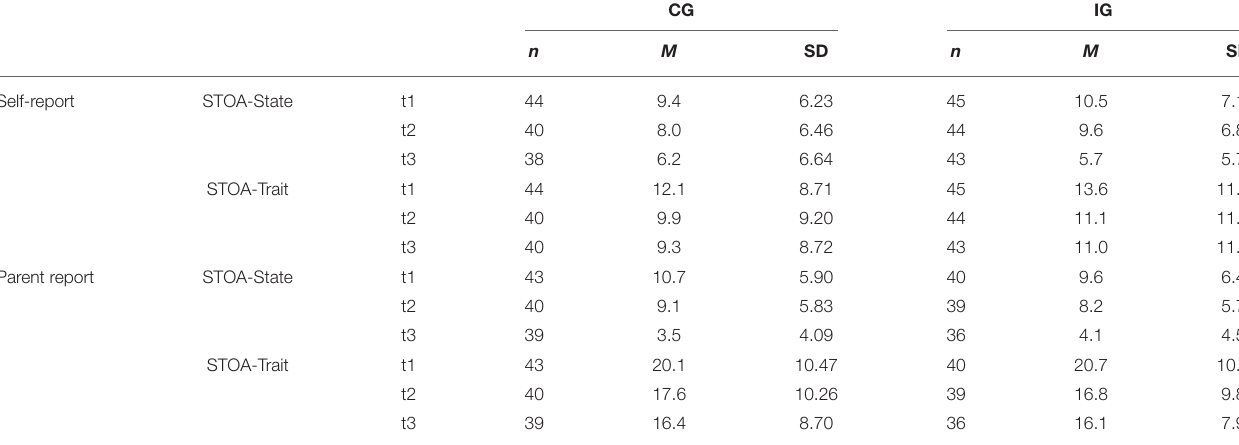
TABLE 2 | Distribution of surgery anxiety before (t1) and after (t2) intervention, and after surgery